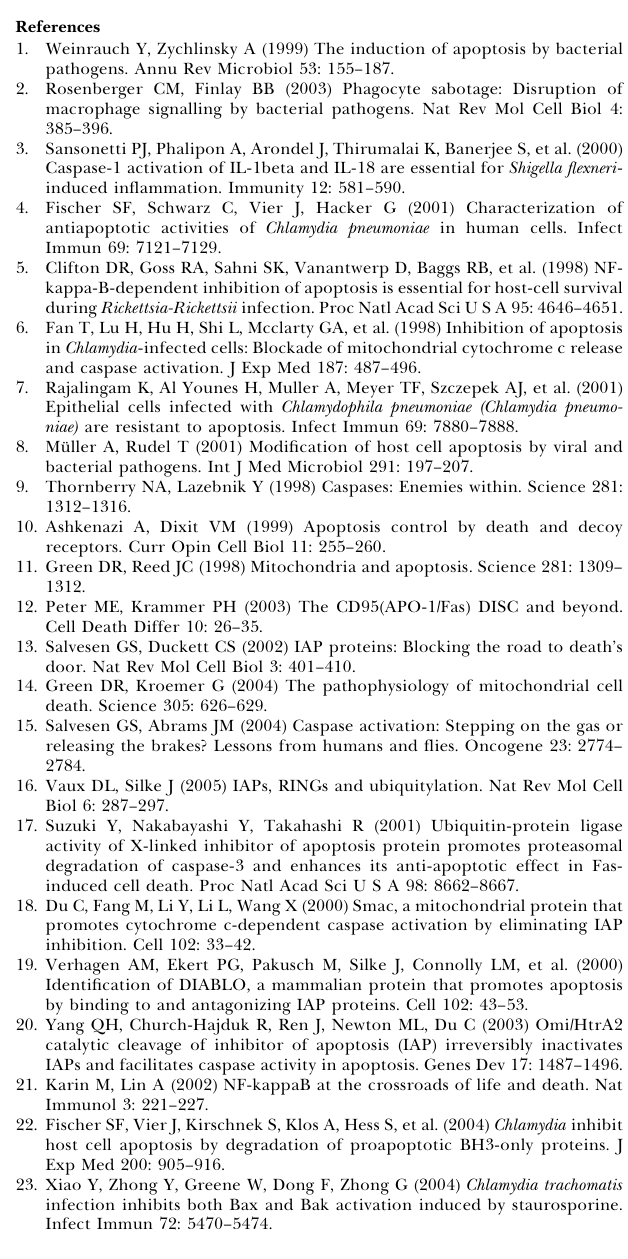
Figure S7. Degradation of cIAP-2 Is Mediated by Proteasomes and Lysosomes (A) Control and shXIAP-expressing cells were infected with Ctr at an MOI of 3 for 16 h and treated with either 5 nM Bafilomycin and/or 10 l M MG132 for 6 h. The cells were lysed as mentioned in Materials and Methods, and the levels of XIAP and cIAP-2 were monitored by immunoblot analysis. Densitometric analysis revealed an increase of 30% of cIAP-2 levels in the infected control compared to the infected XIAP-depleted cells. (B) Control and XIAP-silenced cells were transfected with 1 l g of pcDNA3 (cid:1) cIAP-2 construct and treated with 10 l M of MG132 for 6 h before lysis. Levels of cIAP-2 and XIAP were monitored by immunoblot